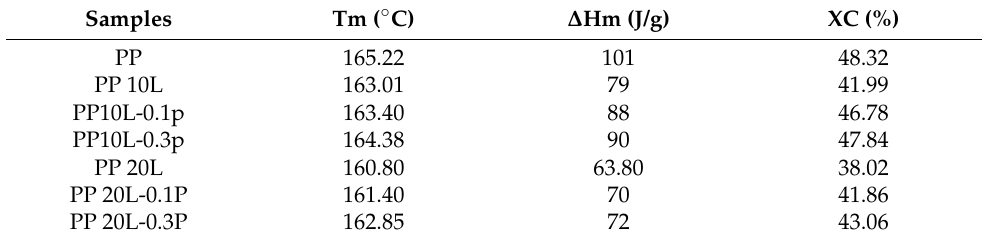
Figure 8. Differential Scanning Calorimetry (DSC) curves of polypropylene, polypropylene/lignin blends sponges, and theirs modified with POSS. Table 4. Differential Scanning Calorimetry (DSC) data of PP and their